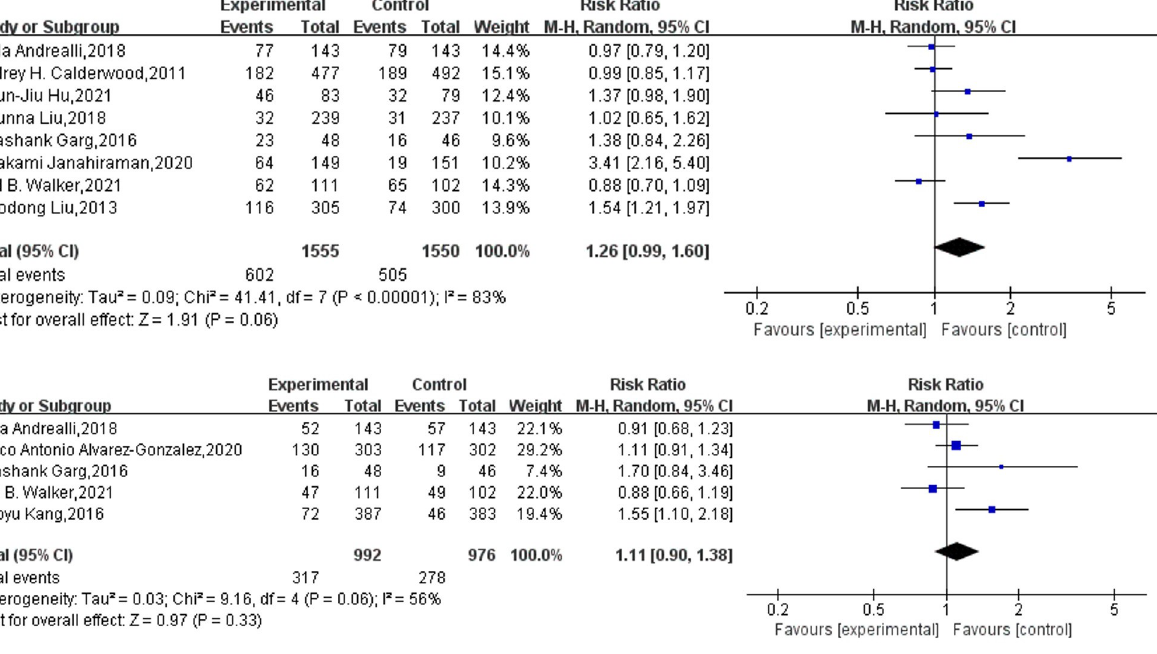
PLOS ONE | https://doi.org/10.1371/journal.pone.0266780 April 21,